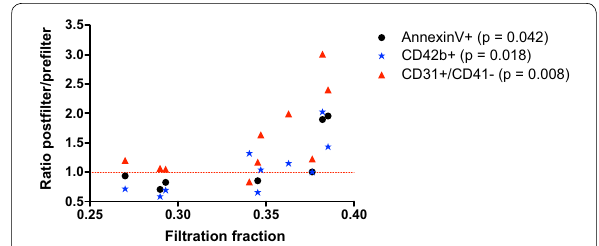
Fig. 2 Correlations of MV subtypes (post- to prefilter Ratios) with filtration